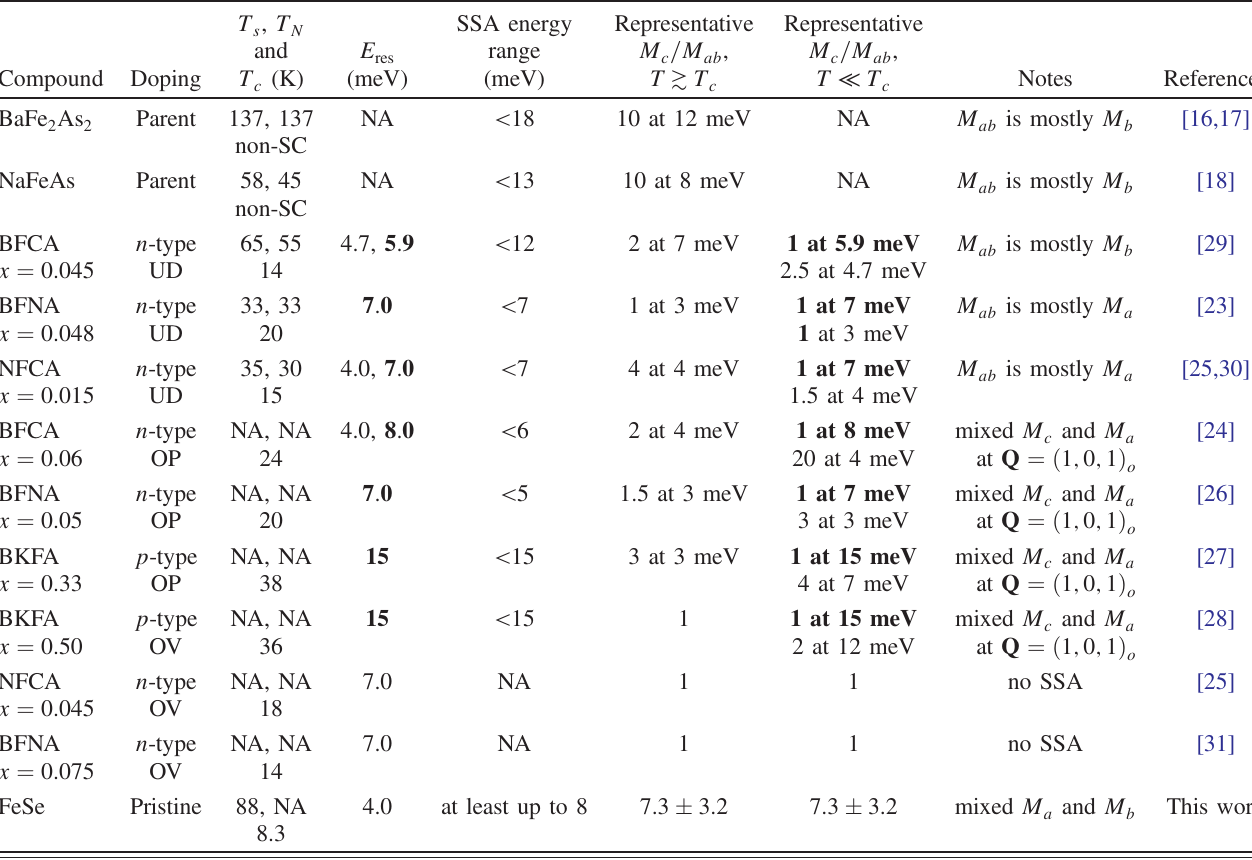
TABLE I. Summary of SSA, in particular, the relative strength of M used in the table: resonance energy ( E (OV). Results for the pnictides are based on measurements near the momentum transfer ð 1 ; 0 ; 1 Þ positions that correspond to the magnetic wave vector in the parent compound. In some of these measurements [24,26 – 28], no attempt was made to separately determine M to indicate the energy of the main spin resonance in the pnictides and the fact that the corresponding INS signal is isotropic in spin